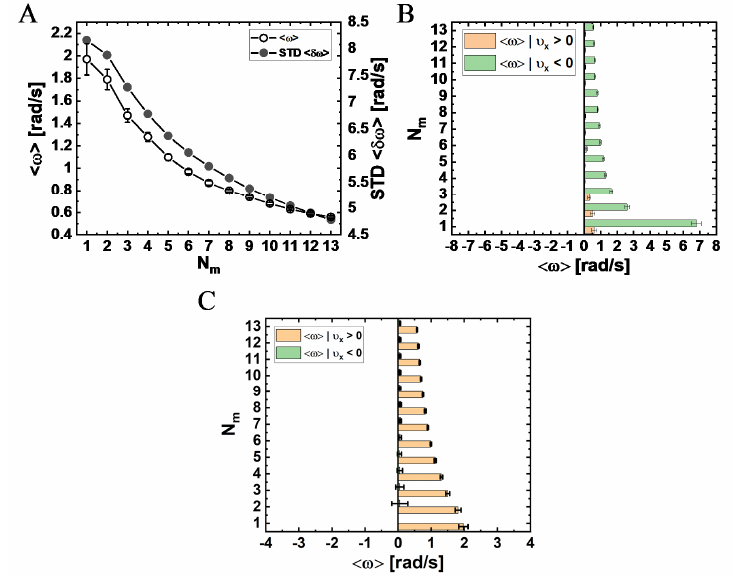
Figure 9. Mean angular velocity, (cid:104) ω (cid:105) , as a function of NP-bound motors, N m , for NPs with a radius of R = 20 nm. ( A ) Mean angular velocity, (cid:104) ω (cid:105) , and the corresponding STD, against N m , for time interval ∆ t = 0.27 s (data are provided in Table S7; see Table S16 and Figure S14 for a ∆ t = MC step time). ( B , C ) Mean ( ± SEM) angular velocity calculated separately for minus-end directed motion, (cid:104) ω (cid:105)| υ x > 0, (orange bars) and plus-end directed motion, (cid:104) ω (cid:105) | υ x < 0, (green bars), against the number of NP-bound motors, N m , for a time interval ∆ t that equals to the MC-step time ( B ); data are provided in Table S18 and 0.27 s ( C ); data are provided in Table S8.